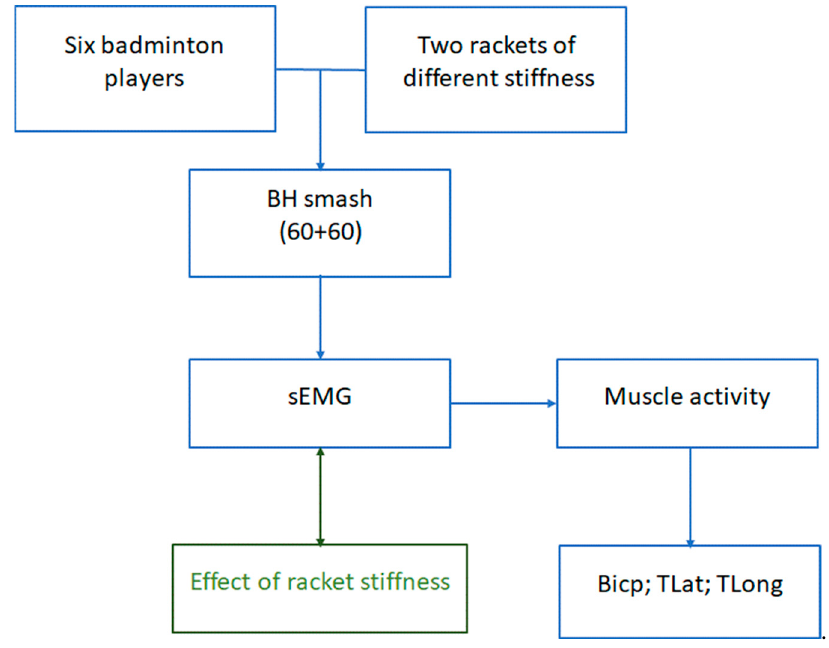
Figure 1. Flow diagram of the experimental